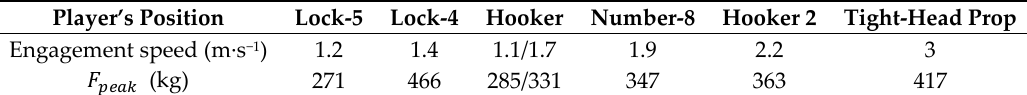
Table 3. Individual peak compression force and engagement speed on the scrum